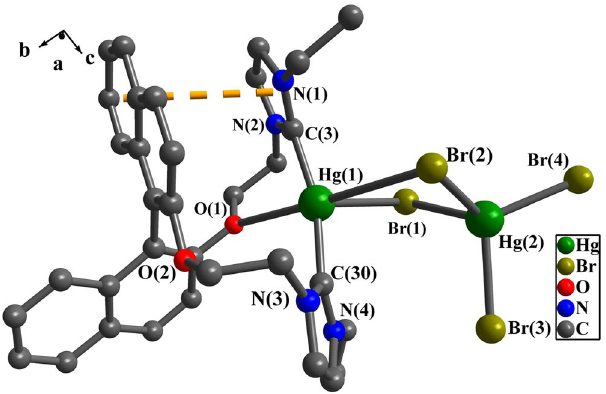
Figure 5. Perspective view of 2 . All hydrogen atoms were omitted for clarity. Selected bond lengths (Å) and angles (°): Hg(1)-C(3) 2.071(9), Hg(1)-C(30) 2.069(8), Hg(1)-Br(1) 3.073(1), Hg(2)-Br(1) 2.682(1), Hg(2)-Br(2)